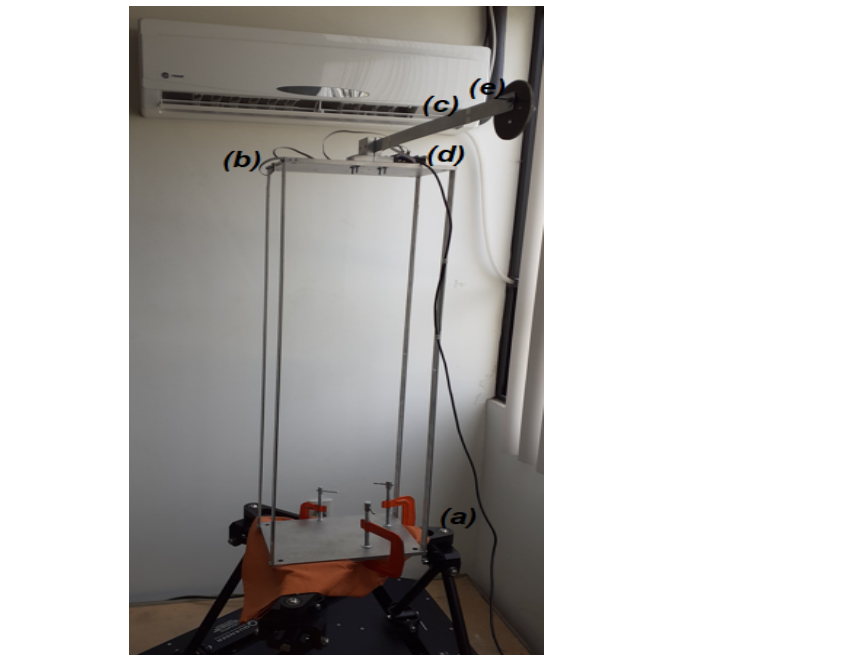
Figure 4. Experimental setup for the second configuration: ( a ) Hexapod Quanser, ( b ) primary system, ( c ) flexible vibration absorber, ( d ) microcontroller, ( e )